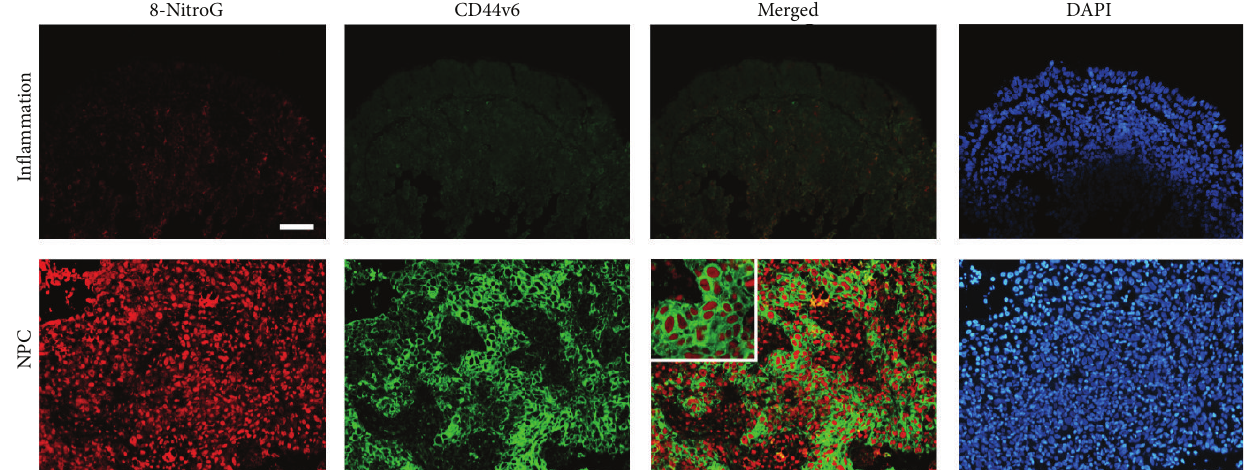
Figure 1: Double immunofluorescence staining of 8-nitroguanine and CD44v6 in chronic nasopharyngitis and NPC tissues. Formalin-fixed and paraffin-embedded biopsies of nasopharyngeal tissues were obtained from chronic nasopharyngitis (inflammation) and NPC tissues. The expression of 8-nitroguanine (red) and CD44v6 (green) were assessed by immunofluorescence staining. Nuclei were counterstained by DAPI (blue). Original magnification is 100x. The enlarged picture is shown in the inset. Scale bar represents 50 𝜇 m.